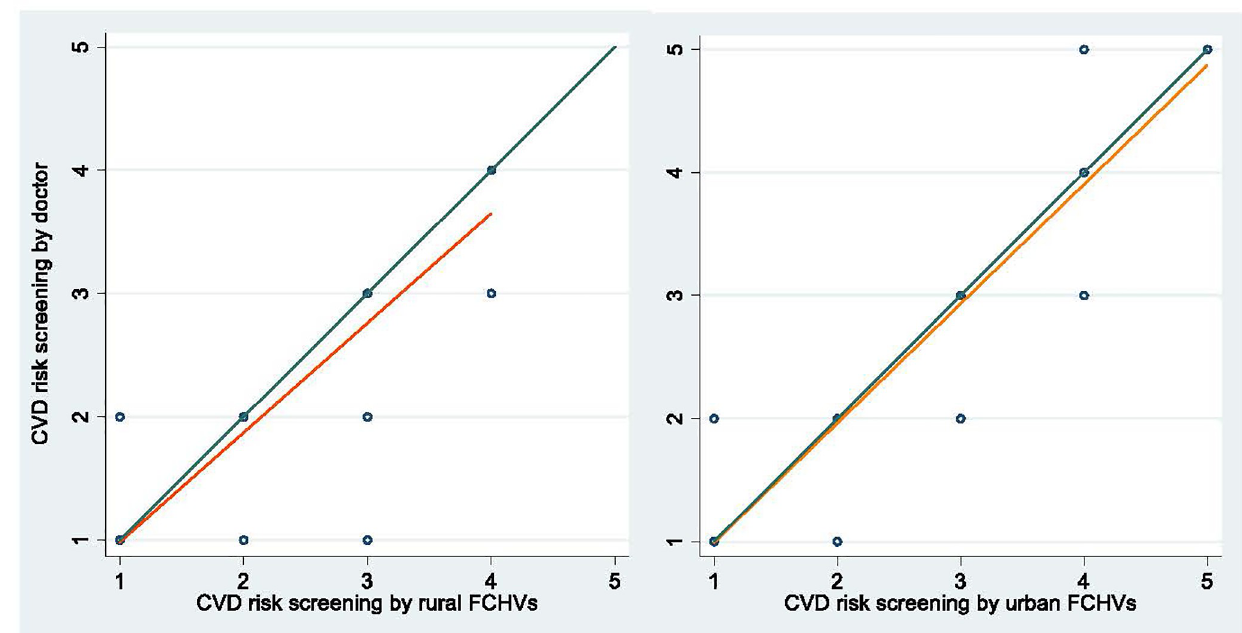
Fig 1. Concordance correlation coefficient for rural and urban sites.